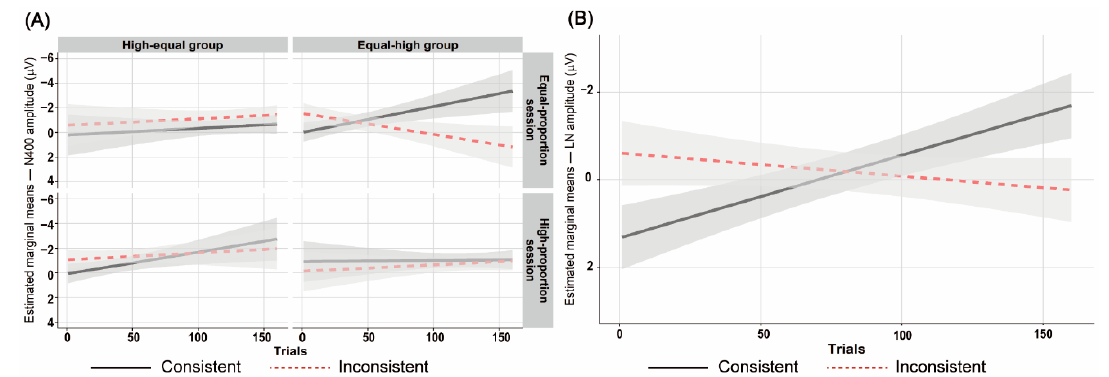
Figure 2. Estimated marginal means for N400 ( A ) and LN ( B ) amplitudes for role nouns. ( A ) The model-based estimates of N400 amplitudes by trials, consistency, session, and order. ( B ) The model- based estimates of LN amplitudes by trials and consistency. Ribbons represent 83% confidence in‑ tervals, the non-overlap of which corresponds to a 5% signi fi cance level (see [46]).